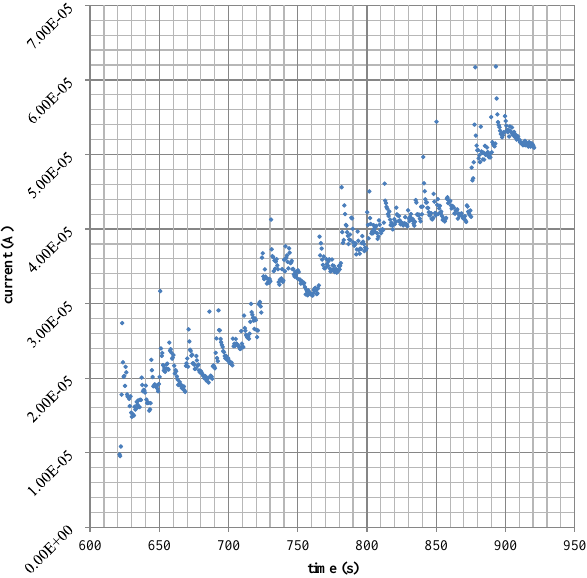
Figure 12. Current flow at a defective passivation at 3V.